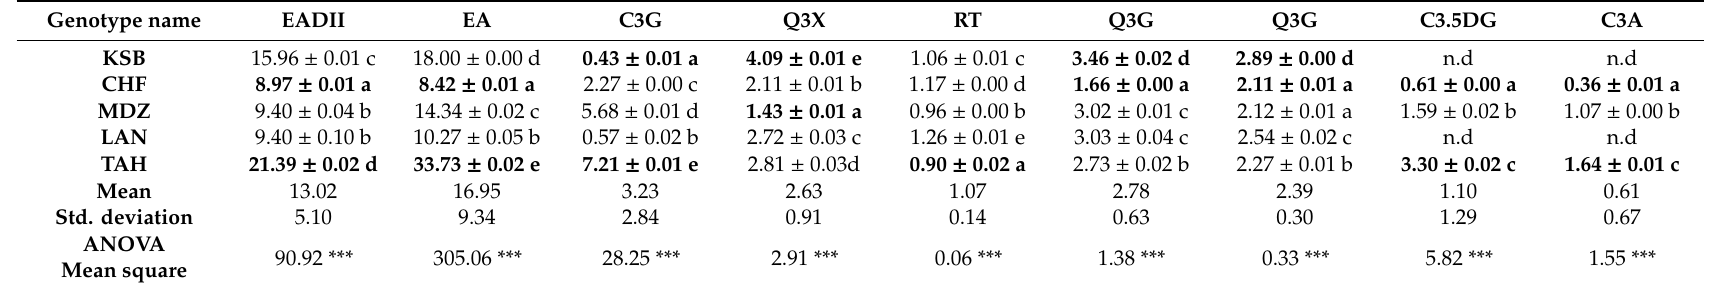
Table 8. Polyphenolic compounds at genotypes site (mean ± SD in mg / 100